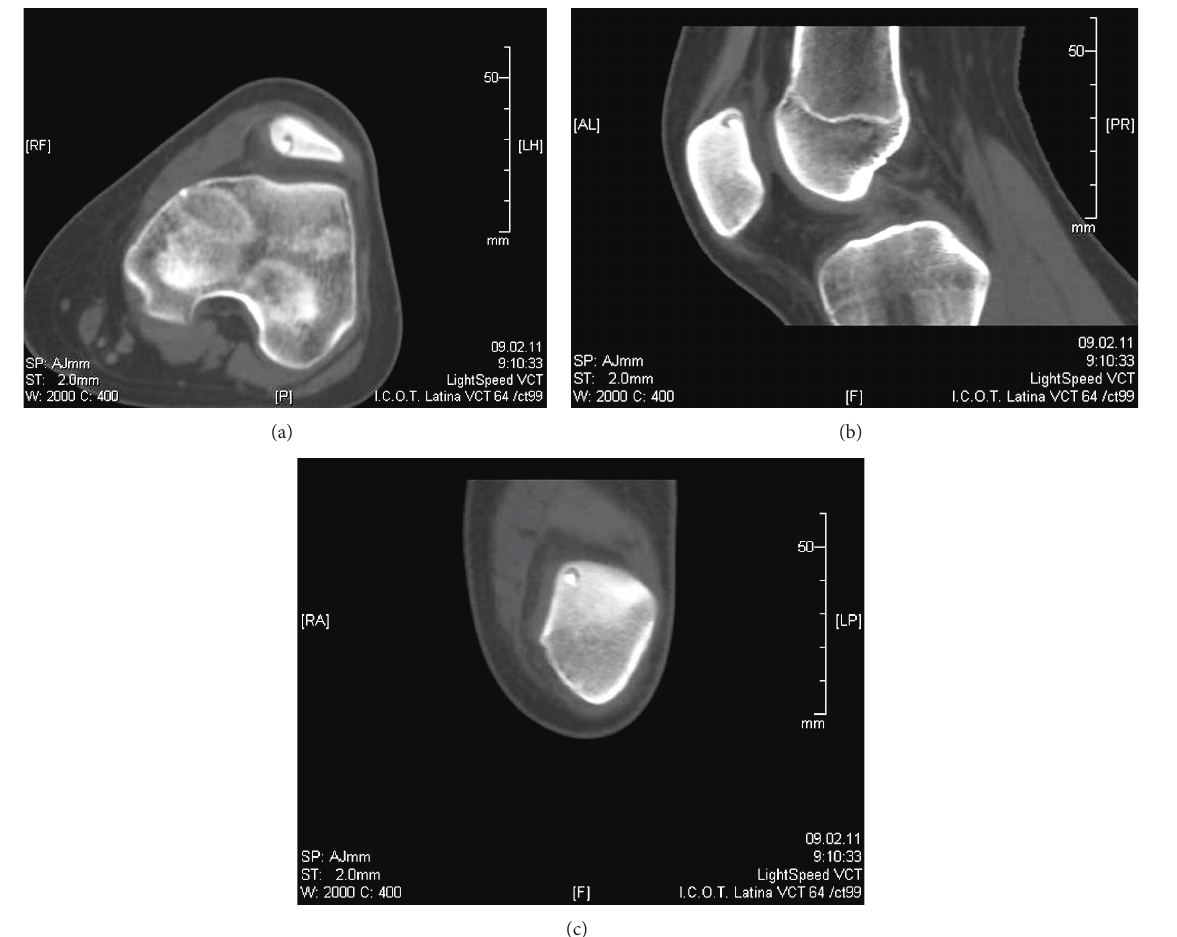
Figure 3: (a) Axial, (b) sagittal, and (c) coronal CT scans show a round, well-marginated sclerotic lesion of about 8 mm with a hypodense rim and a centrally calcified